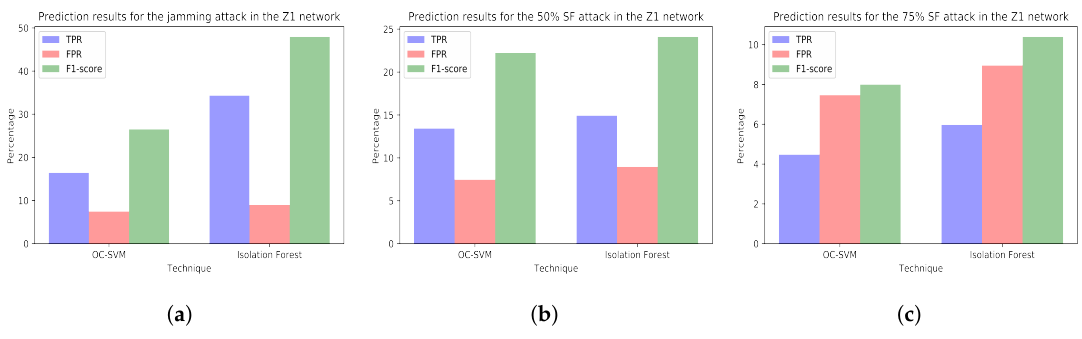
Figure 10. ( a ) prediction results for the jamming attack period using the variables from Z1 network (training with dataset tr_z1 and test with dataset te_z1_jam ); ( b ) prediction results for the 50% selective forwarding attack period using the variables from Z1 network (training with dataset tr_z1 and test with dataset te_z1_sf50 ); ( c ) prediction results for the 75% selective forwarding attack period using the variables from Z1 network (training with dataset tr_z1 and test with dataset te_z1_sf75 ).